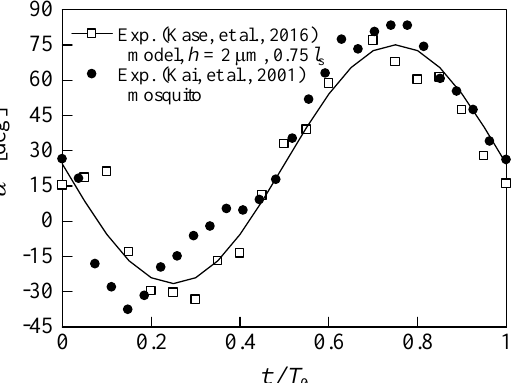
Fig. 4 Periodic changes of the inclination angle  for the model and mosquito wings. This figure is a reproduction of Ref. (Kase, et al., 2016) for the marker at 0.75 l . The experimental results of Ref. (Kai, et al., 2001) were s measured at (0.7-0.8) l of a mosquito wing. The solid line is a least-square approximation to the open s